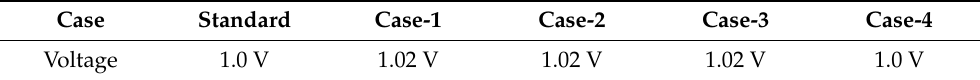
Figure 8. Location of the sensor with respect to the nut. Table 3. Variation in measured voltage according to the relative locations of the sensor and nut.